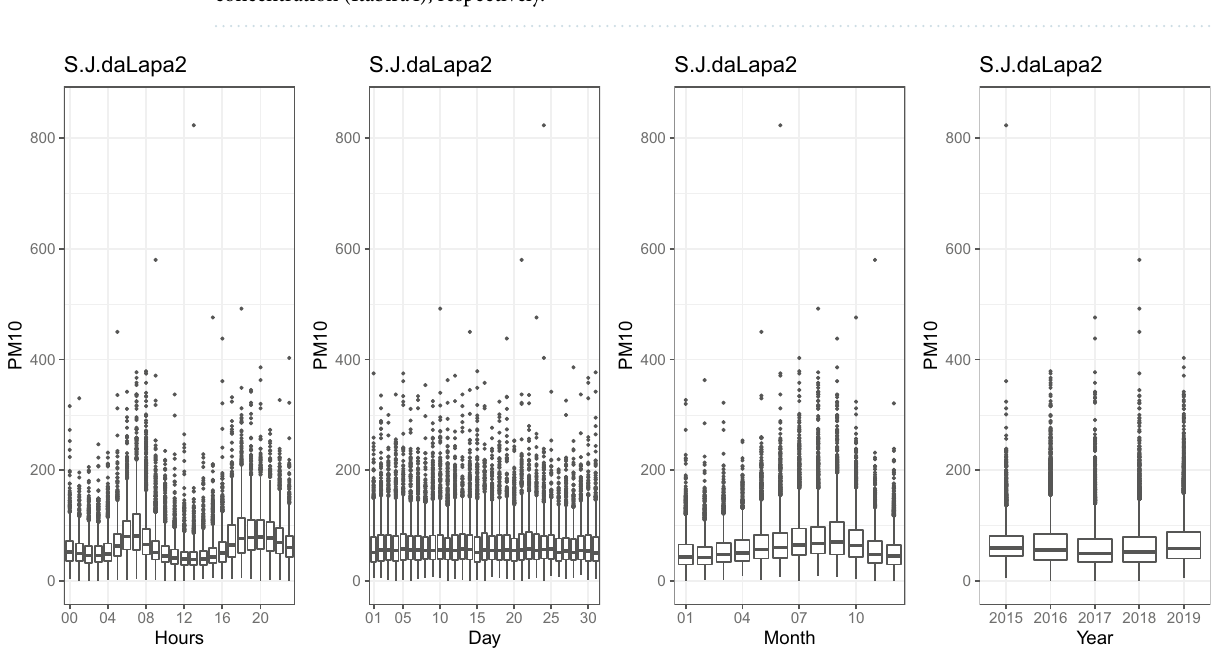
Figure 5. Hourly, daily, monthly and yearly boxplots for the monitoring station with the highest average of PM 10 concentration (S.JdaLapa2),